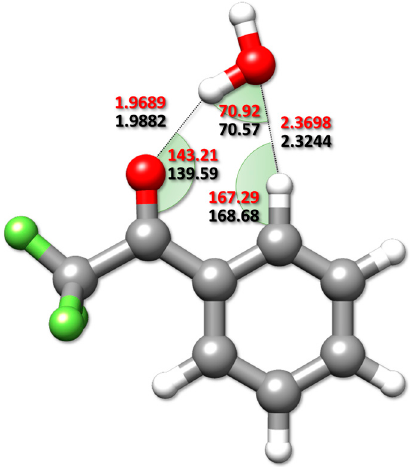
Figure 3. Comparison between the semi-experimental intermolecular parameters (in red) with the rDSDjun counterparts (in black). Distances and angles are given in Å and degrees, respectively.